Question: Generate an informative caption for the figure above.
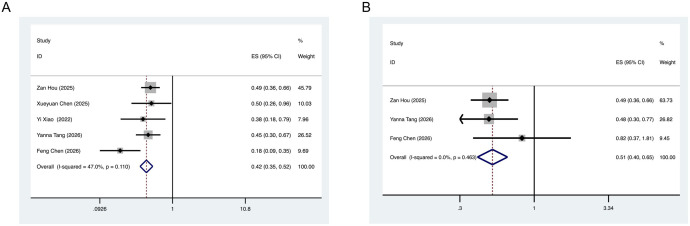
Answer: Updated meta-analysis: forest plot of hazard ratios for PFS (A) and OS (B) in patients with PLELC receiving first-line chemo-immunotherapy versus chemotherapy alone. PLELC, pulmonary lymphoepithelioma-like carcinoma;PFS, Progression-Free Survival;OS, overall survival.